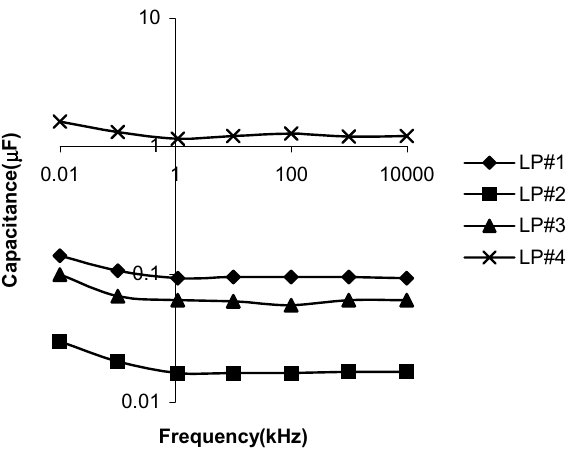
Figure 5. The variation of capacitance against frequency for the In at low vacuum pressure.